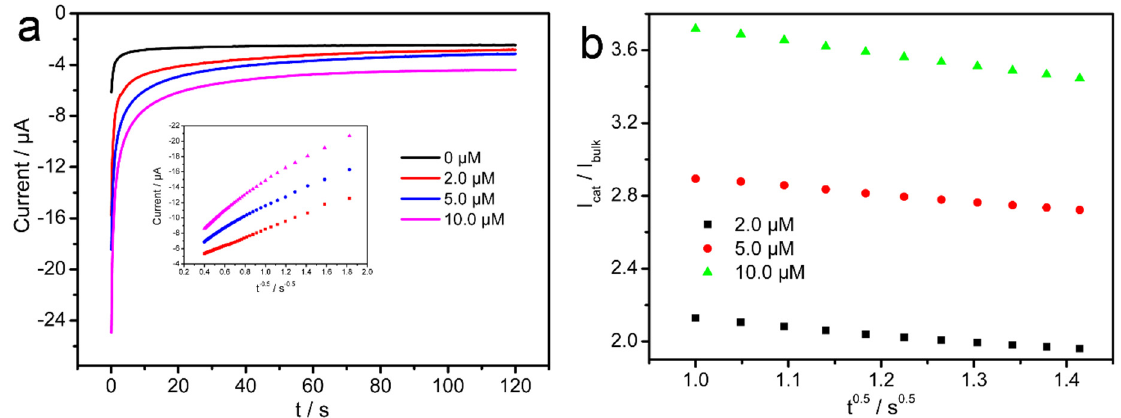
Figure 6. ( a ) Current–time curves on the PQT@GCA electrode in 0.2 mol/L NaClO 4 containing different glucose concentrations. The inset is the linear relationship between t − 0.5 and the current. ( b ) The linear relationship between the square roots of time and the catalytic current ( I cat ) ratio to blank current ( I bulk ).